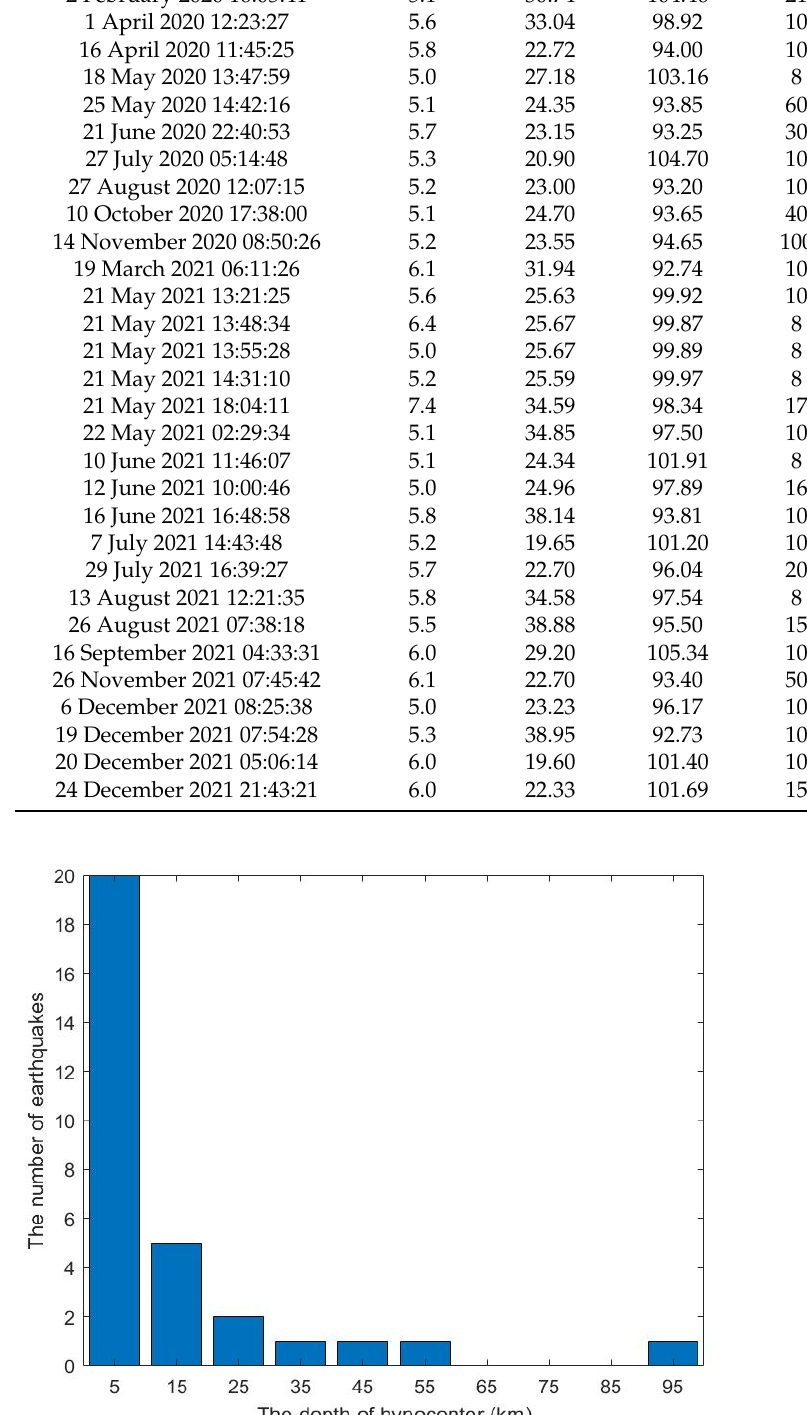
Figure 2. The distribution of hypocenter depths.